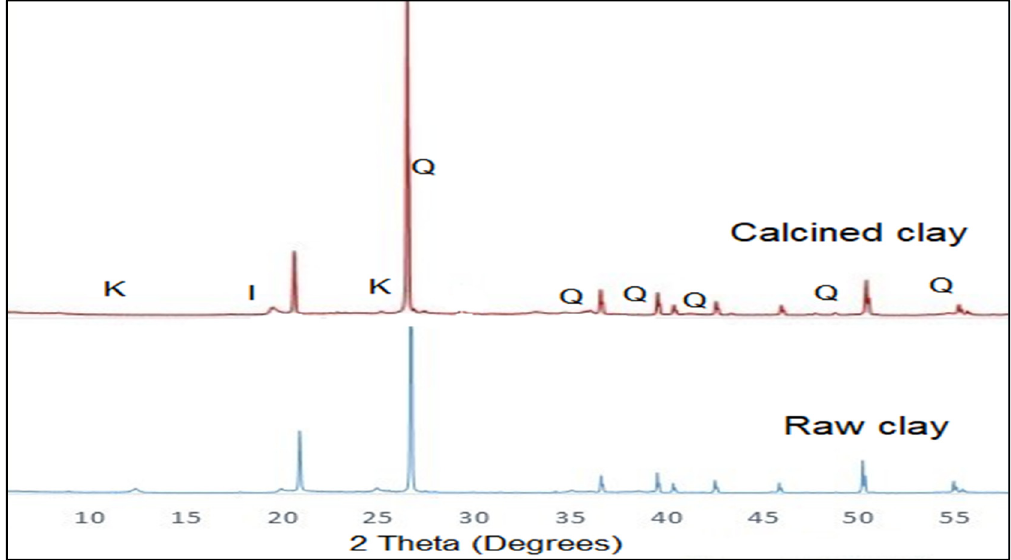
Figure 5. XRD of raw and calcined clay ( Q-Quartz; K-Kaolinite; I-Illite ).